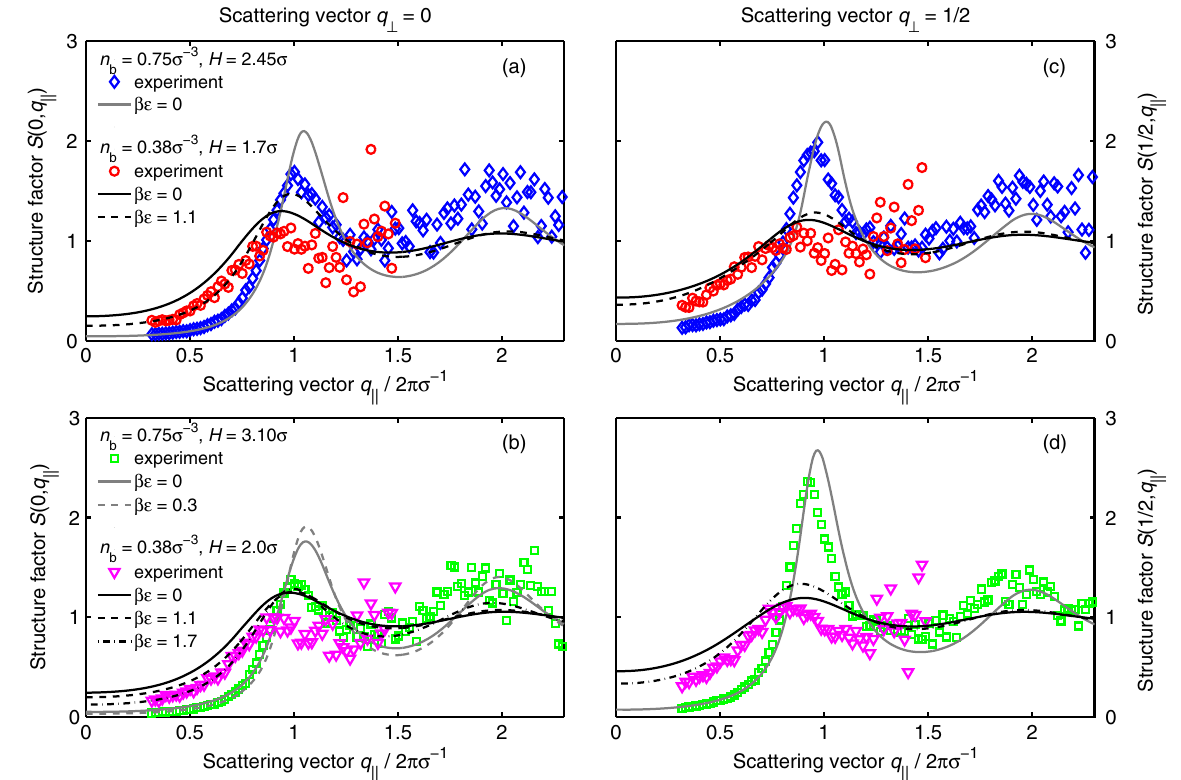
FIG. 7. In-plane structure factor for the confined hard-sphere fluid, presented as a function of parallel scattering vector component q ∥ for either q ⊥ ¼ 0 (left panels) or 1 = 2 (right panels). Experimental data are shown for the dense fluid in slits of width H ¼ 2 . 45 σ (blue diamonds) and 3 . 10 σ (green squares) as well as for the moderately dense fluid in slits of width H ¼ 1 . 7 σ (red circles) and 2 . 0 σ (magenta triangles). The lines depict corresponding theoretical data obtained within the APY theory for either hard or slightly sticky hard surfaces. Plots (a) and (b) (to the left in the figure) are relevant for the extrapolation to q ¼ 0